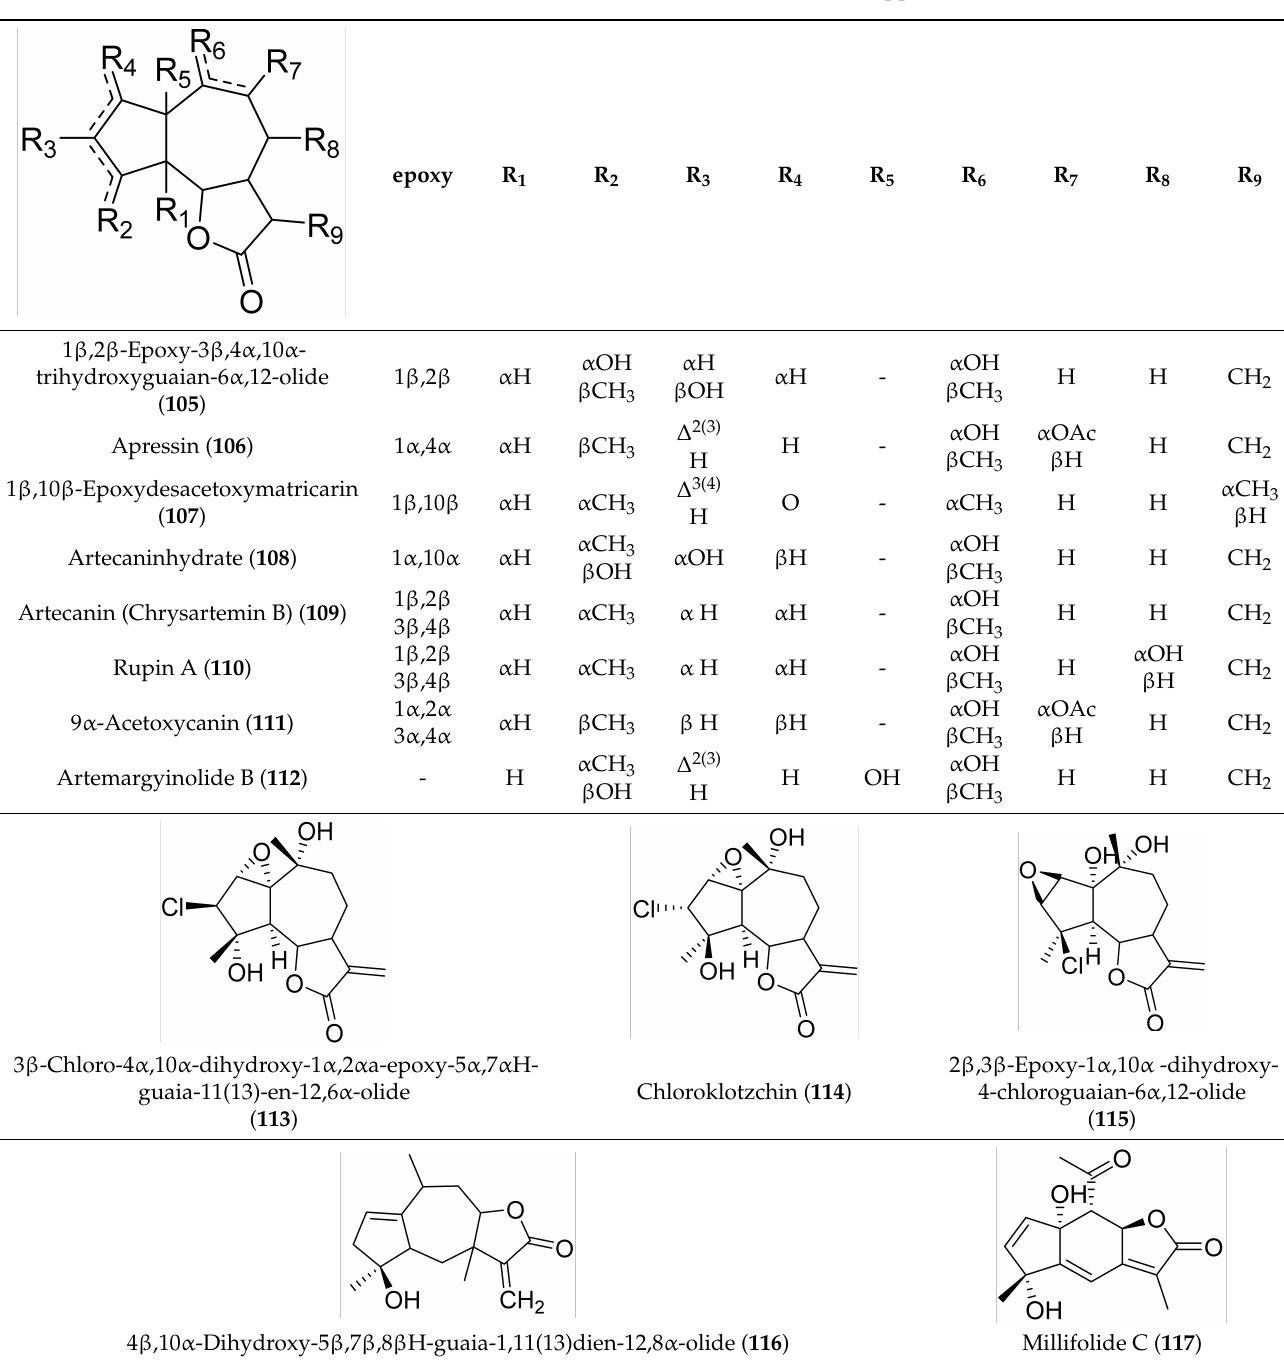
Table 9. Chemical structures of Guaianolides from Achillea spp. Part